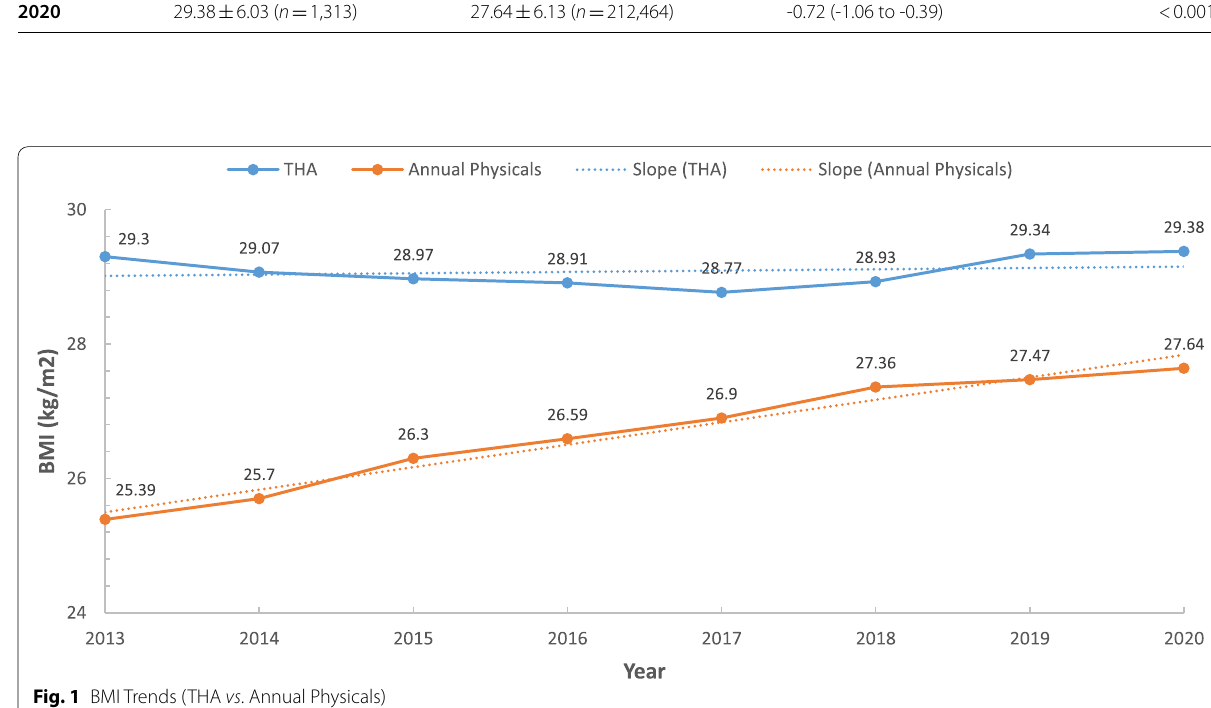
Fig. 1 BMI Trends (THA vs . Annual